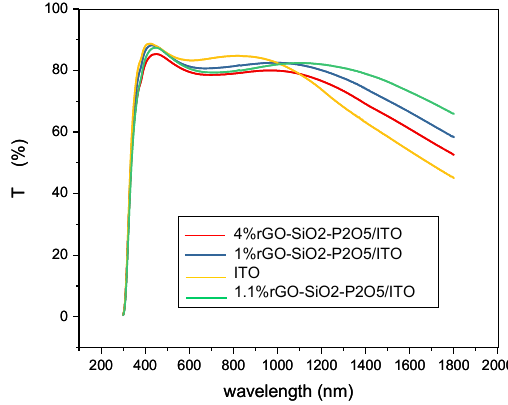
Figure 15. UV-VIS-NIR spectra of the sol-gel films deposited on ITO-coated glass